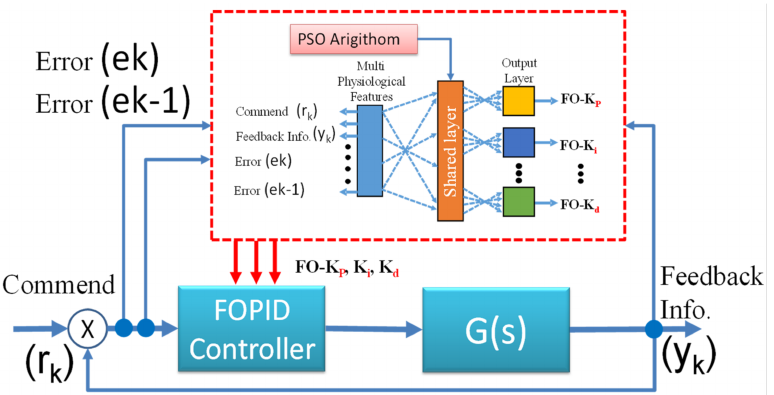
Figure 5. The neural network’s design and structure for motor